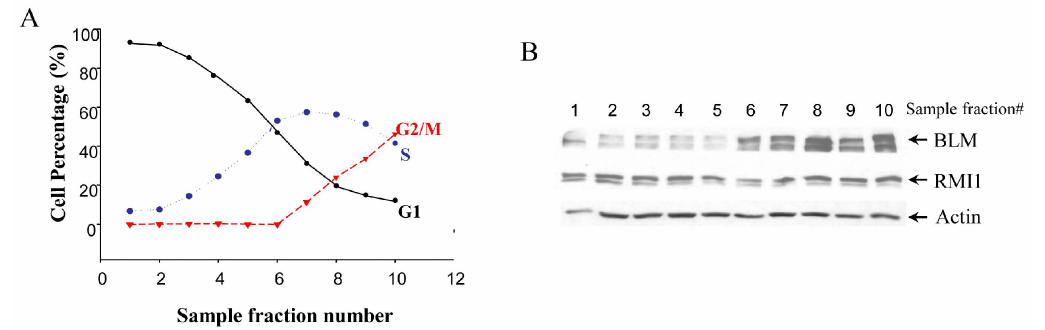
Figure 1. Levels of RMI1 protein (RecQ-mediated genome instability protein 1) in cycling HeLa cells. ( A ) HeLa cells were synchronized by centrifugal elutriation. The cell cycle distribution of each fraction was determined by flow cytometry; ( B ) Total proteins were extracted from each fraction cells and analyzed for protein levels of RMI1 and BLM by immunoblotting. Numbers above the panel denote individual elutriated fractions.